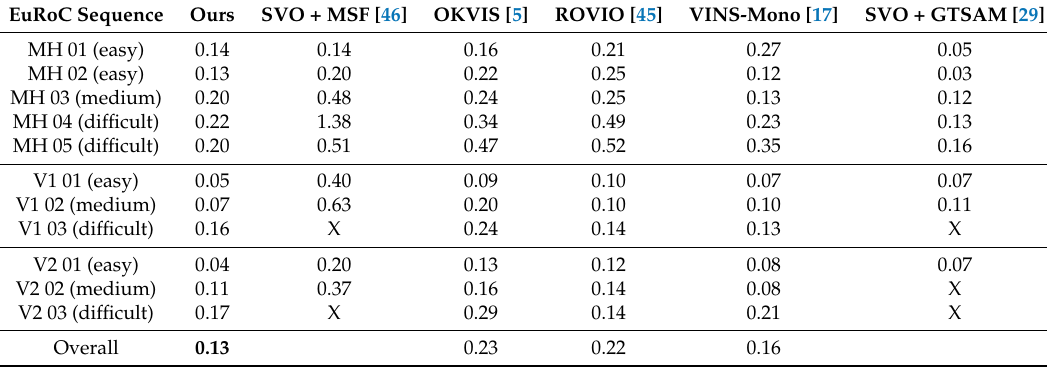
Table 1. Average distance error on the EuRoC dataset (unit: